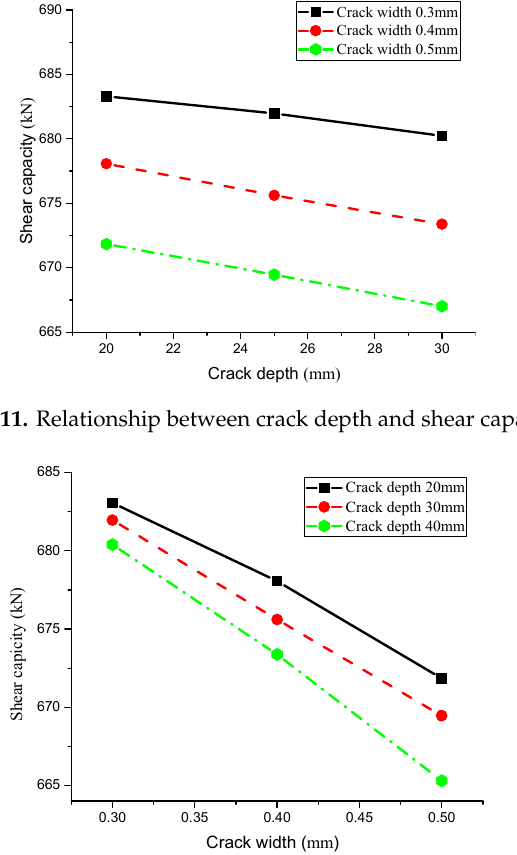
Figure 13. Shear strength attenuation curve.